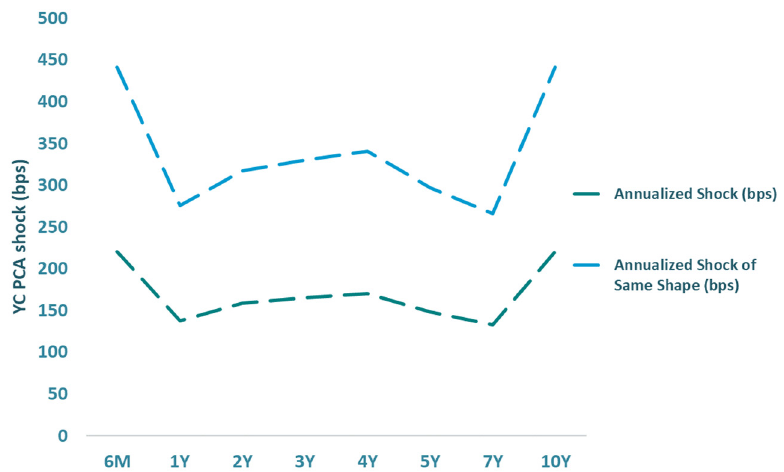
Figure 16. One-standard-deviation annualized yield curve shocks of the same shape corresponding to the first three principal components combined, on 25 March 2022. Source: Bloomberg yields, own computation.